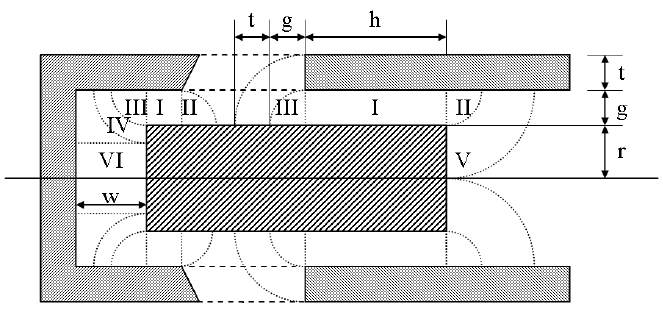
Figure 6. Simplification of the six types of magnetic path. Table 1. The air gaps flux path model calculations.